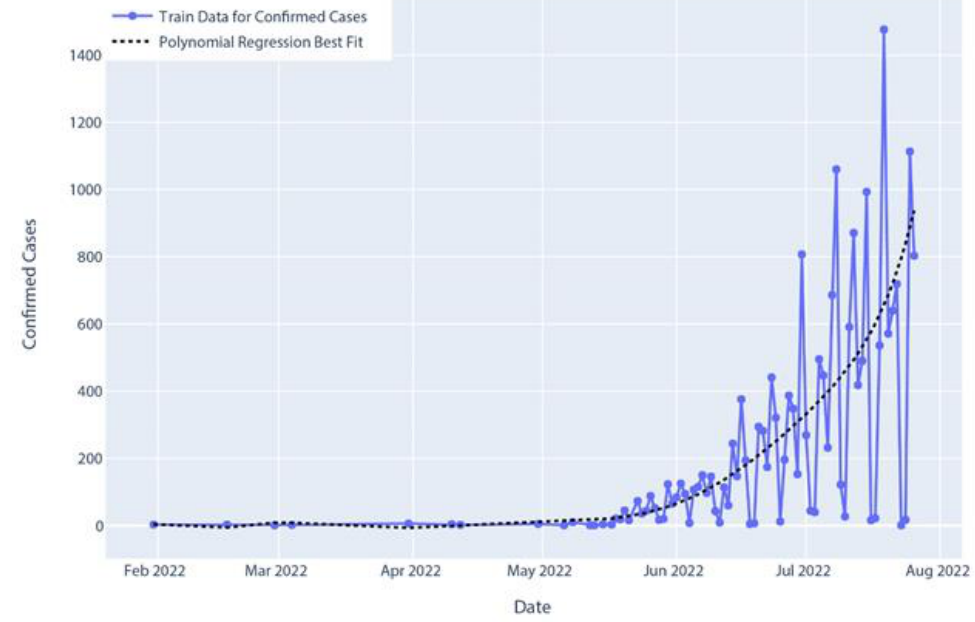
Figure 15. Confirmed cases of polynomial regression model prediction.